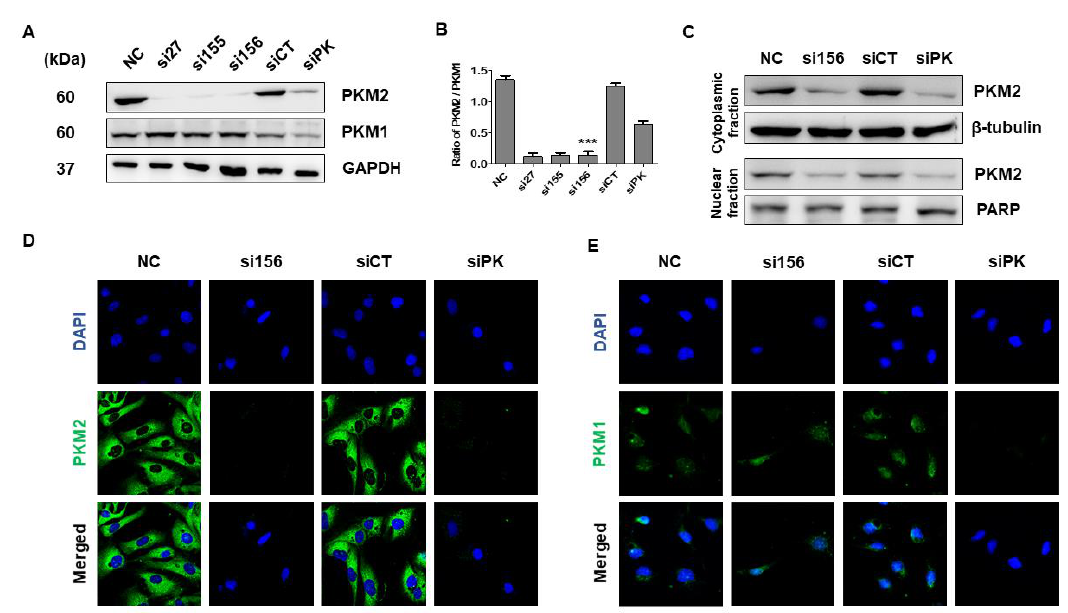
Figure 2. E ff ect of small interfering RNA (siRNA) transfection on PKM2 and PKM1 expression. ( A ) Expression level of PKM2 was drastically reduced in cells transfected with indicated PKM2 siRNAs. No changes were observed in PKM1 expression level after PKM2 siRNA transfection. PKM1 expression level was reduced after transfection with siPK. Glyceraldehyde 3-phosphate dehydrogenase (GAPDH) was used as internal loading control. ( B ) Statistical quantification of immunoblot bands of PKM2/PKM1. One-way ANOVA was used to compare means of various groups. Alterations between mean values were considered significant at p < 0.05 using Tukey’s multiple comparison test; *** p < 0.001 as compared with normal control cells. ( C ) Western blot analysis of expression level of PKM2 in cytoplasmic and nuclear fractions of 786-O cells after transfection with indicated siRNAs. β-Tubulin and poly (ADP-ribose) polymerase (PARP) were used as internal loading controls for cytoplasmic and nuclear fractions, respectively. ( D , E ) Immunofluorescence analysis of PKM1 and PKM2 expression after siRNA transfection at 400× magnification. PKM2 siRNA transfection drastically reduced PKM2 expression in the cytoplasm and nucleus, as confirmed by the absence of PKM2 green signal compared with normal and negative control cells. Positive control siPK also reduced PKM2 expression. PKM1 was expressed in normal and siCT- and si156-transfected 786-O cells. Expression of PKM1 protein was reduced in siPK-transfected cells as compared with other groups. 4,6-diamidino-2-phenylindole dihydrochloride (DAPI) was used for nuclear staining, and Alexa Fluor 488-conjugated goat anti-rabbit antibody was used to detect PKM2 and PKM1 expression. si27, si155, and si156: experimental siRNAs targeting PKM2 mRNA; siPK: commercially available siRNA targeting both PKM1 and PKM2 mRNAs (positive control); and siCT (siControl): siRNA targeting the firefly luciferase gene (negative control).